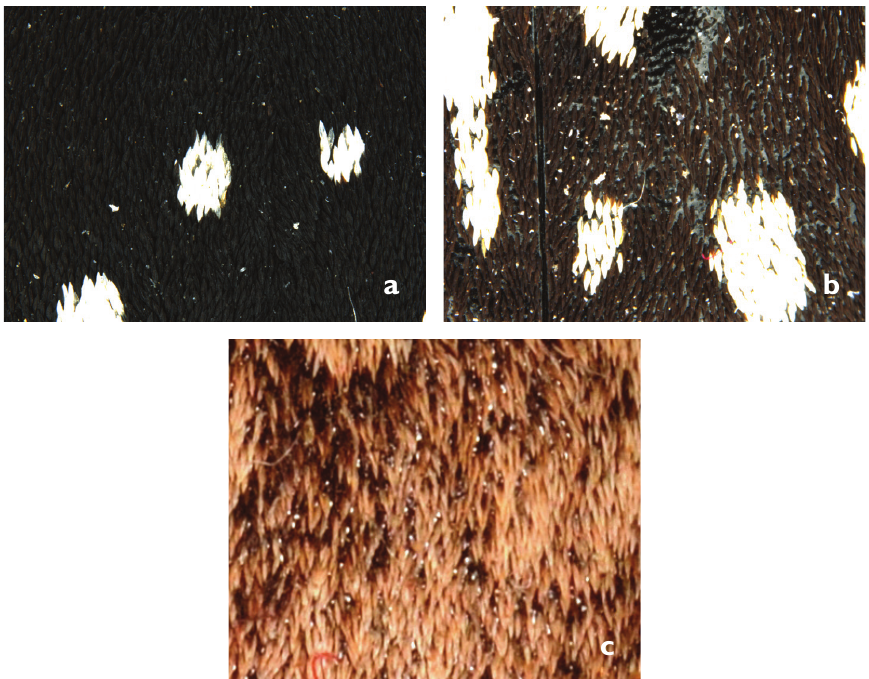
Figure 6. Elytral scale coloration: a Black dense scales ( G. serrator ) b Dark brown sparse scales ( G. reymondi ) c White slushy scales ( G. barthelemyi ).